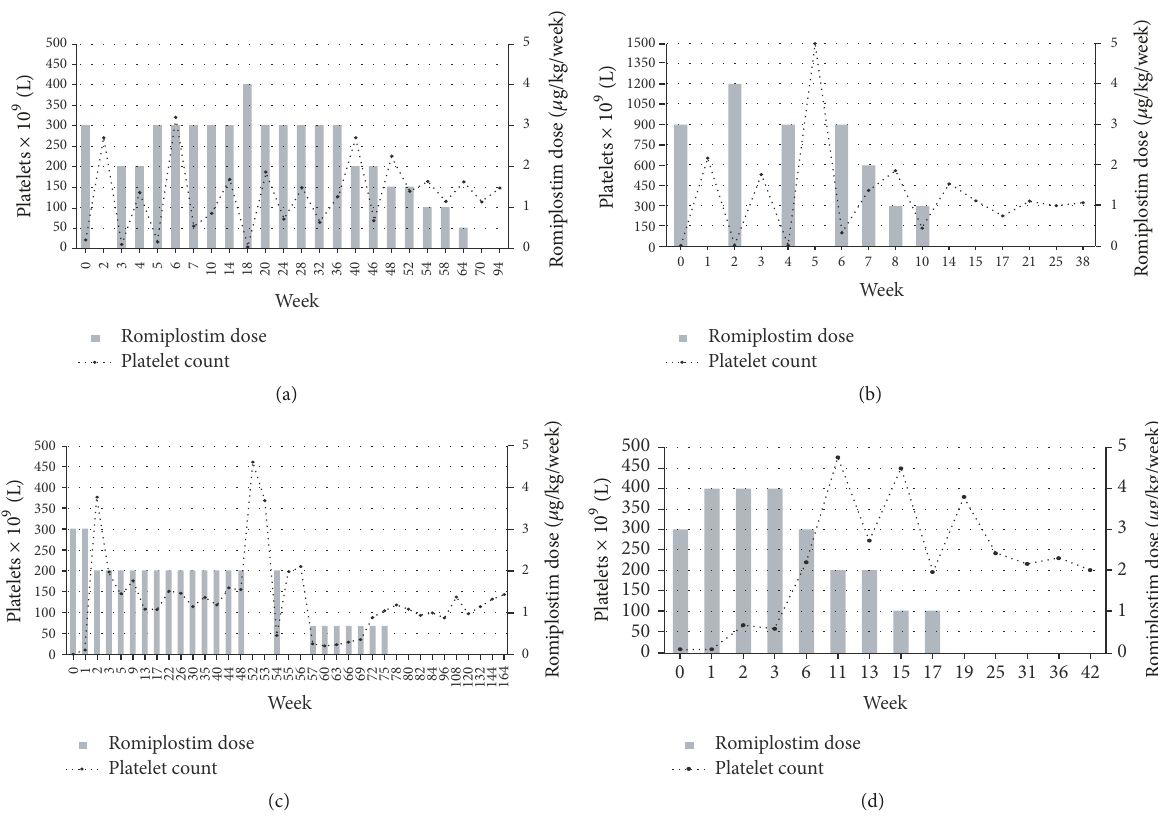
Figure 1: Platelet count and romiplostim dose evolution: (a) case 1: newly diagnosed ITP; (b) case 2: persistent ITP; (c) case 3: chronic ITP; splenectomized; (d) case 4: chronic ITP;